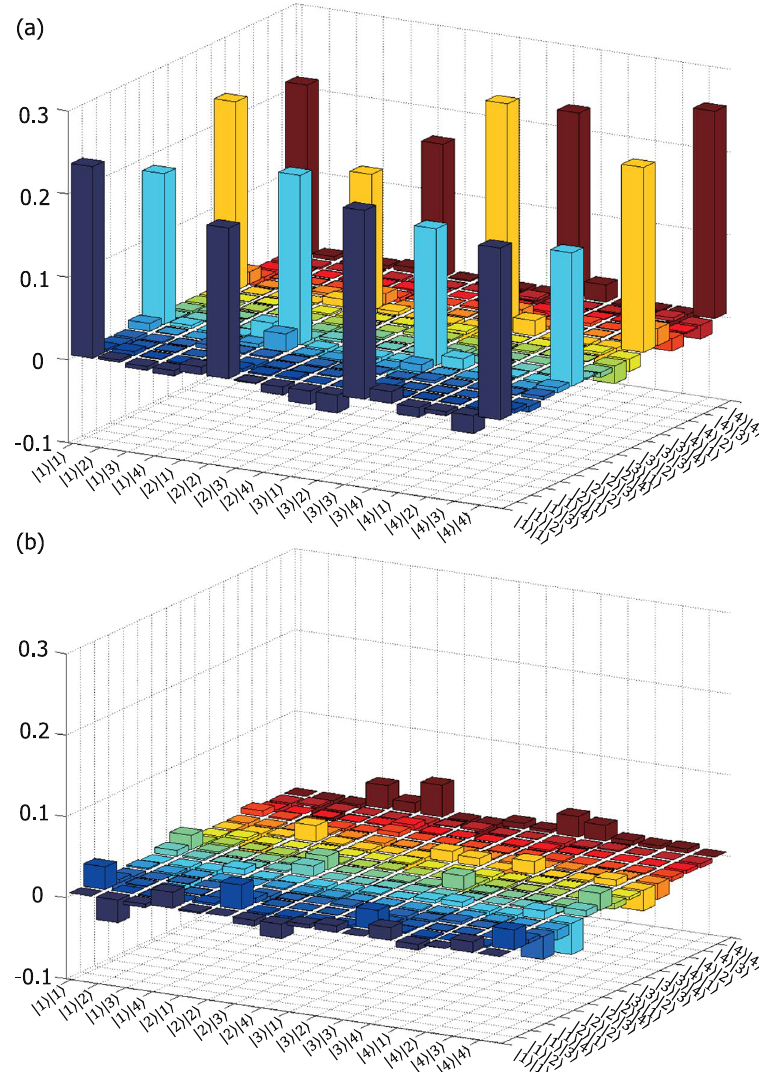
Figure 5. Two-ququart density matrix ρ ˆ reconstructed by quantum state tomography: ( a ) real and ( b ) imaginary parts.